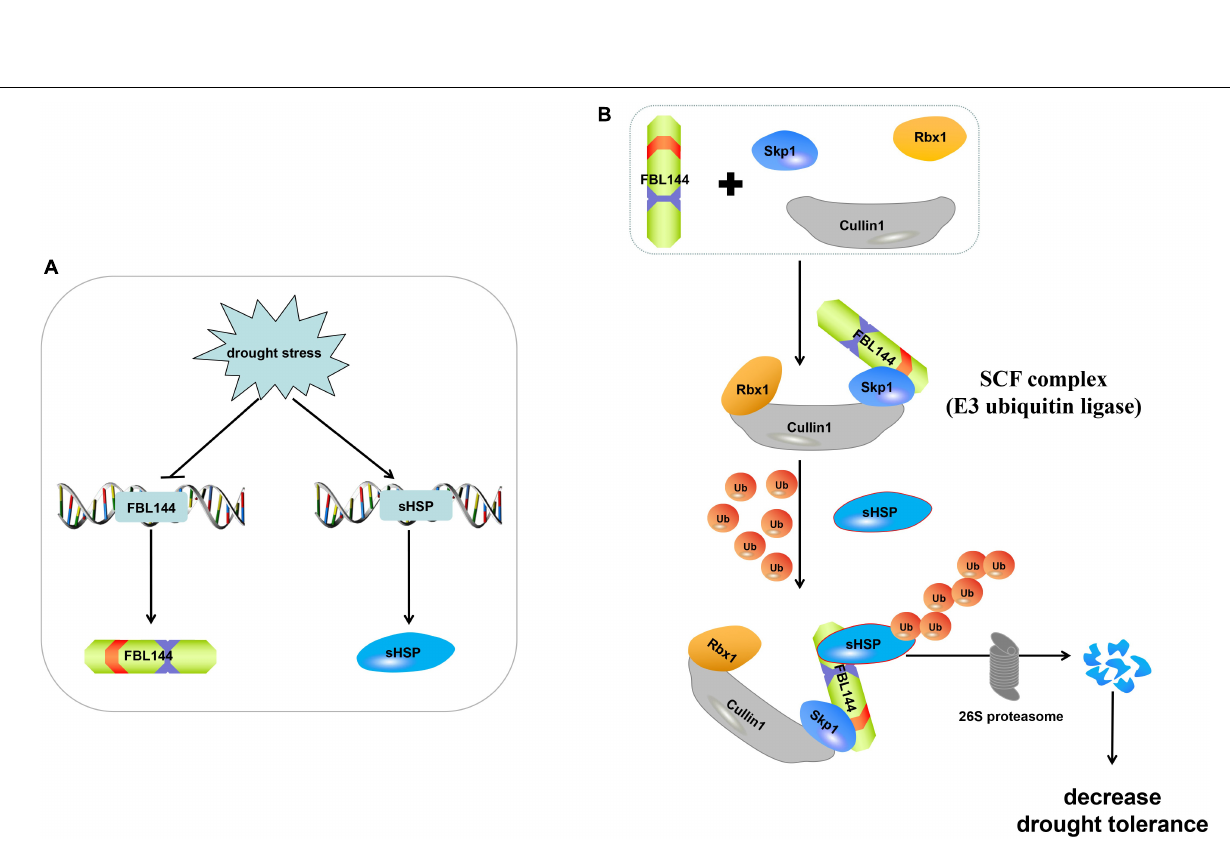
FIGURE 7 | Screening and identification of GmFBL144 interacting proteins. Quality identification of primary library (A) and sub-library (B) . Recombination rate = successful recombinant clones (24)/total clones (24) × 100%, library capacity = total clones (1300)/spreading volume (0.05 mL) × dilution multiple (100) × total volume (4 mL). Interaction of GmFBL144 with GmsHSP was verification by Y2H (C) and BiFC (D) . nYFP denotes the YFP N-terminal protein. cYFP denotes the YFP C-terminal protein. Scale bars = 25 µ m. (E) Phenotype of heterologous expression of GmsHSP in yeast under drought stress (1 M mannitol).